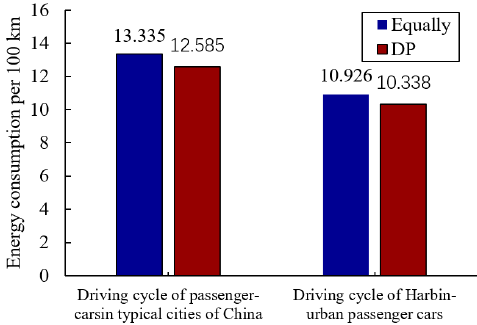
Figure 16. The energy consumption under different driving cycle and different control strategies.